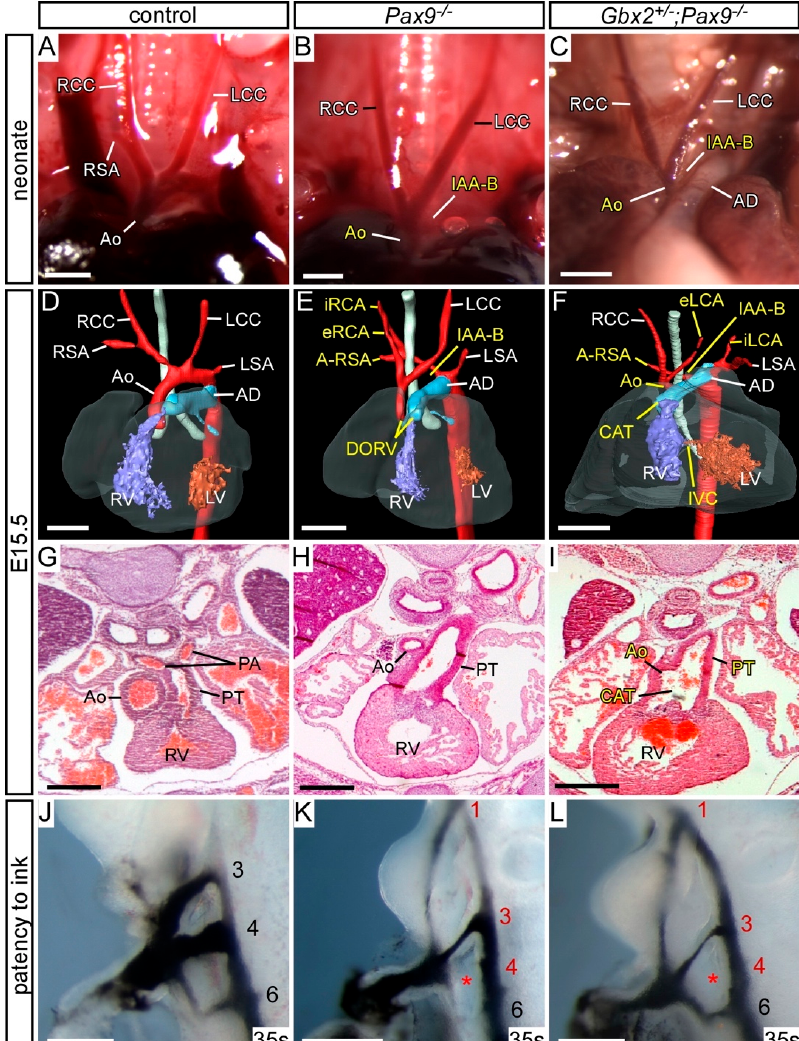
+/ − ;Pax9 − / − mice. ( A – C ) Neonates were dissected on the Figure 5. Cardiovascular defects in Gbx2 +/– ;Pax9 –/– mice. ( A–C ) Neonates were dissected on the day of Figure 5. Cardiovascular defects in Gbx2